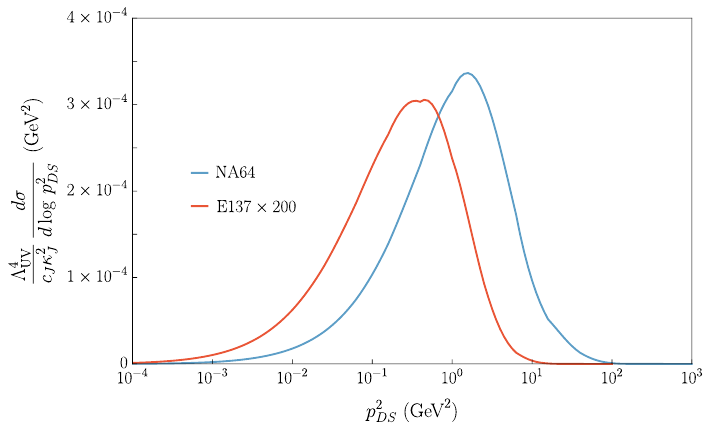
Figure 10 . Differential cross section for DS production as a function of the DS invariant mass squared at NA64 and E137. The NA64 curve is obtained by imposing the cut E dark photon cross section, and performing the cut E